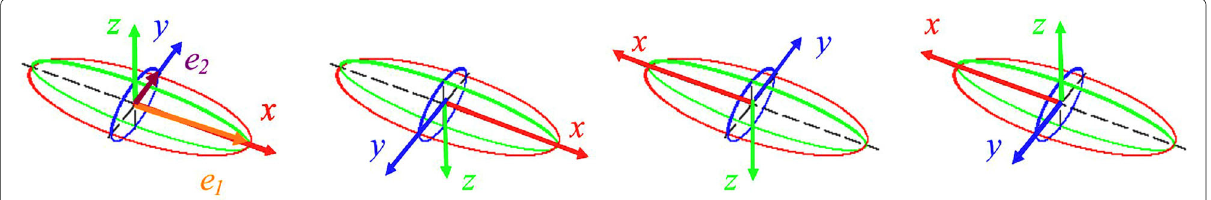
Fig. 8 The four possible intrinsic reference frames as proposed and developed by